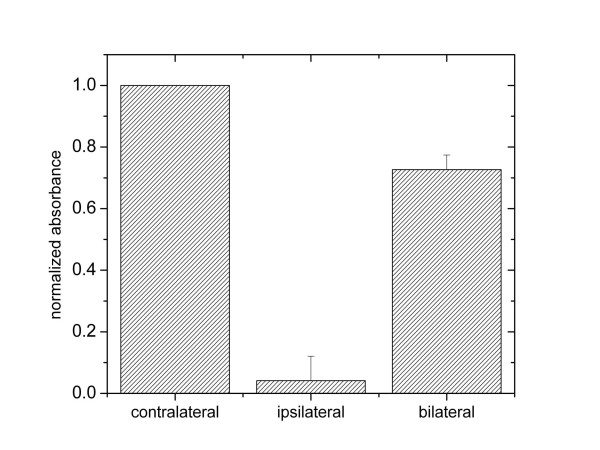
Comparison of averaged normalized absorbance values (n = 5) evoked under 3 different stimulus conditions. Values were normalized to those obtained from the contralateral stimulus condition (thus, standard error bar for the contralateral condition is zero) and were obtained at 5 sec after stimulus onset of a 5 sec flutter stimulus. The contralateral stimulus evoked the greatest change in absorbance, while the ipsilateral stimulus evoked the weakest. The bilateral stimulus evoked a cortical response that was less than the response evoked by the contralateral stimulus. Analysis of variance showed that, at a 99% confidence interval, the ratio of the bilateral response evoked to the contralateral response evoked in SI was between 0.51 and 0.92.